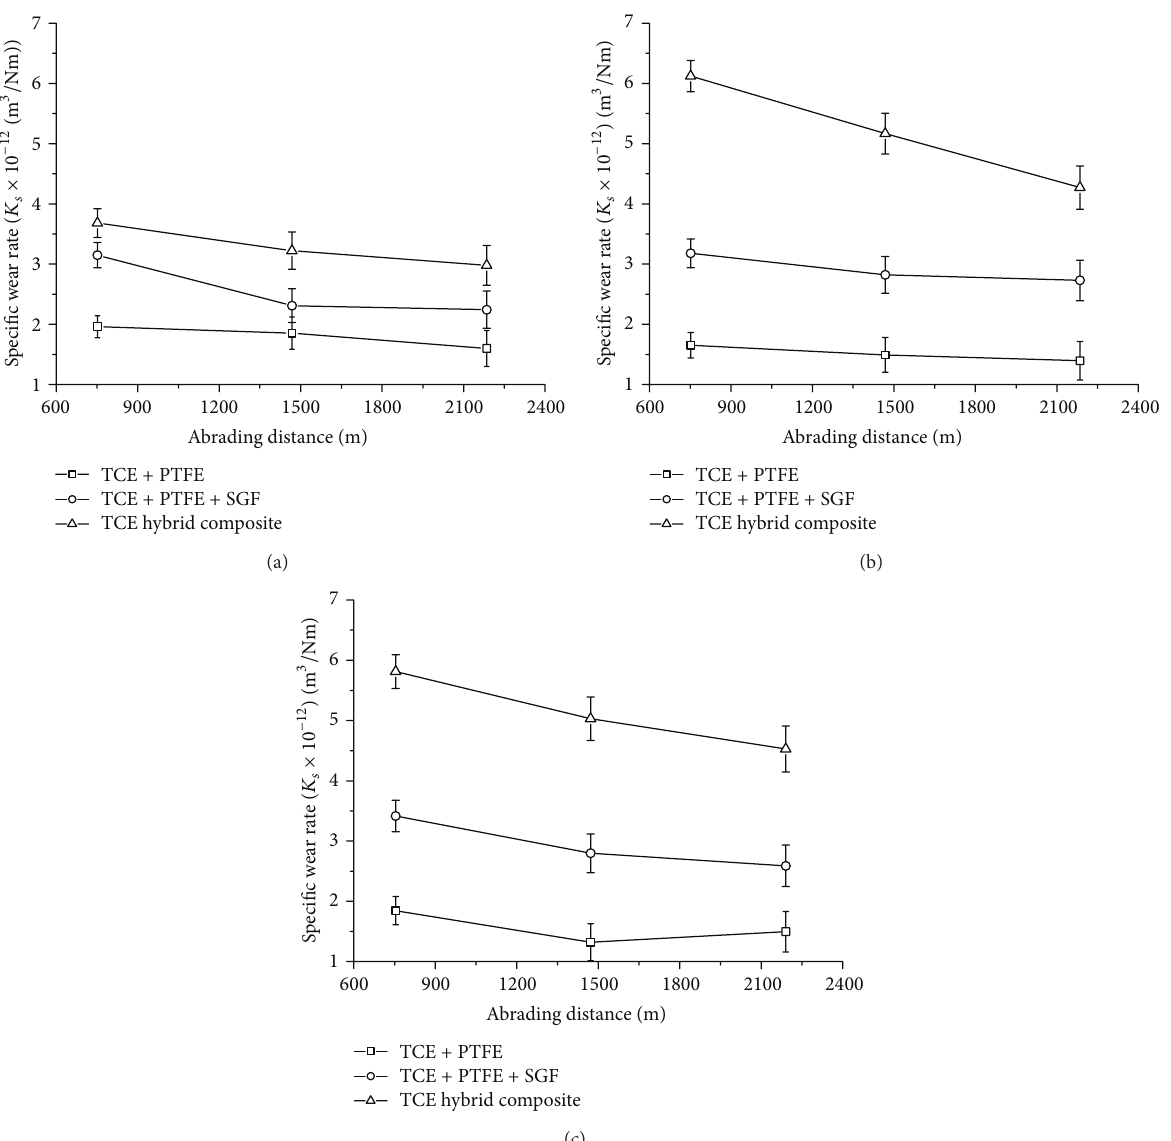
Figure 3: (a) Effect of abrading distance on 𝐾 𝑠 of TCE + PTFE filled hybrid composites at 40 N (212 𝜇 m silica sand). (b) Effect of abrading distance on 𝐾 𝑠 of TCE + PTFE filled hybrid composites at 40 N (425 𝜇 m silica sand). (c) Effect of abrading distance on 𝐾 𝑠 of TCE + PTFE filled hybrid composites at 40N (600 𝜇 m silica